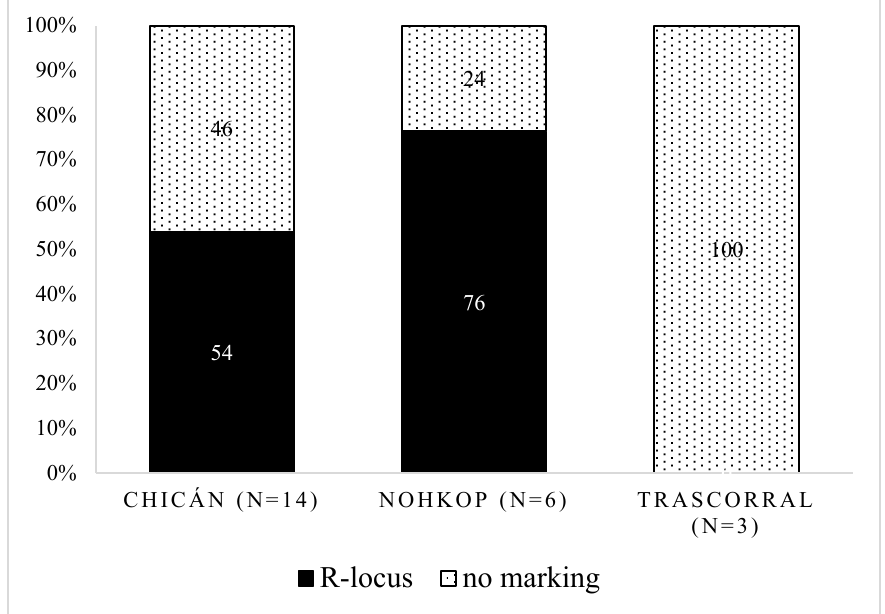
Figure 3. Total number of responses in percentages compared by communities for R-locus vs. no- marking.